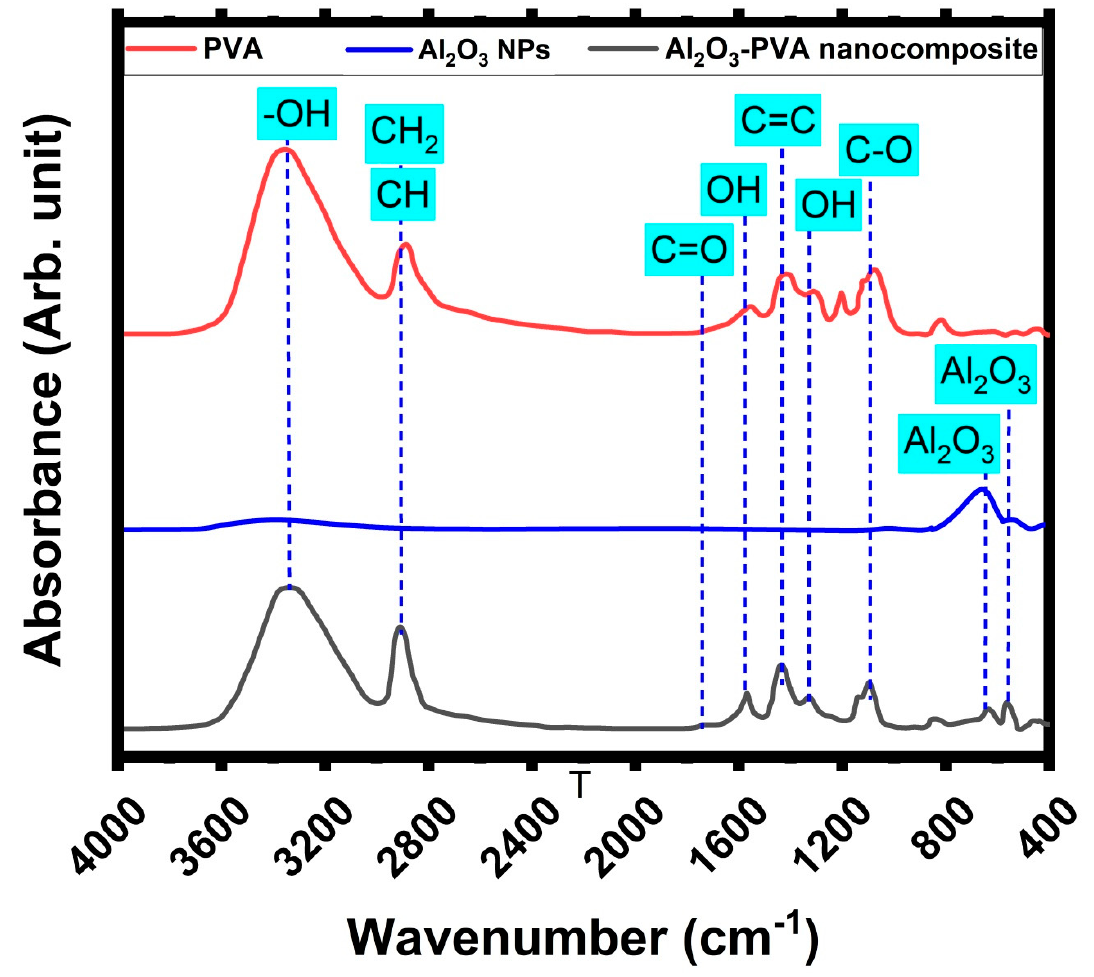
Figure 2. FT-IR spectra of PVA, Al 2 O 3 nanoparticles, and Al 2 O 3 /PVA nanocomposite. FESEM was used to investigate the morphological changes in PVA caused by embedding with Al 2 O 3 molecules as mentioned in Figure 3. The micrographs exhibit SEM of Al 2 O 3 nanoparticles, PVA, and the hybrid with PVA-Al 2 O 3 nanocomposite. The surface of the produced structure from the laser ablation of the Al sheet in the ultra-pure water showed a semi-spherical shape in the nanoscale form, while the SEM image of the PVA structure showed a uniform surface shape that reveals dispersed smooth microspores instead of uniform ones. Moreover, the surface of the polymer was significantly distorted during metal oxide contact, and the metal oxide particles were uniformly dispersed over the polymer surface compared to the pure PVA structure. As a result, the change in the surface of the PVA-Al 2 O 3 nanocomposite reveals that the PVA surface was highly deformed, and the aluminum oxides were homogeneously distribution throughout the PVA surface.